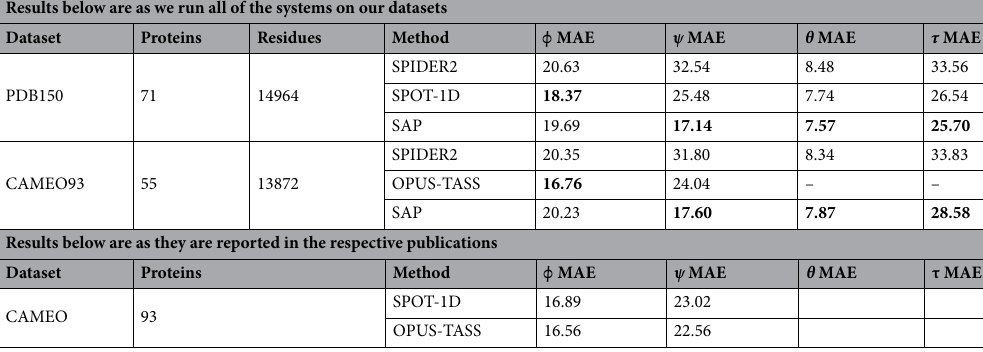
Table 6. Performances of SPIDER2, SPOT-1D, OPUS-TASS, and SAP on filtered PDB150 and CAMEO93 proteins. The emboldened values are the wining numbers for the corresponding types of angles and datasets. OPUS-TASS does not predict θ and τ angles while the other three methods predict all four types of angles.